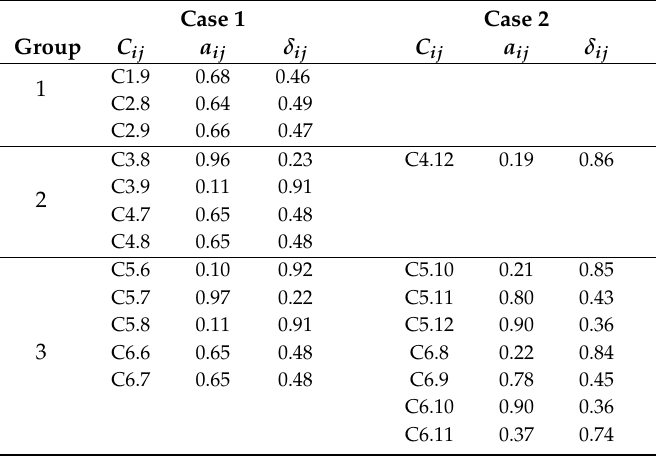
Table 7. Shaded area and shading ratio for polycrystalline PV module YL290p-35b.